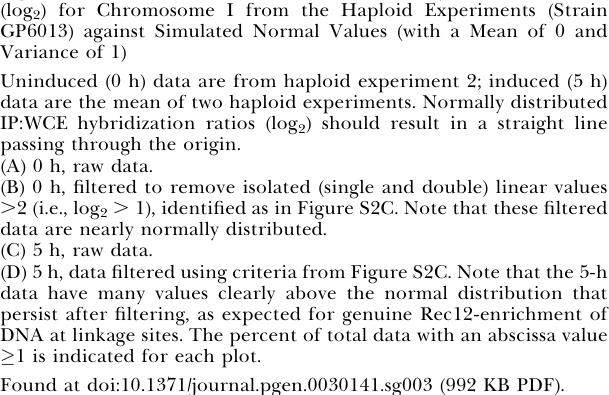
Figure S4. Quantile-Quantile Plots of IP:WCE Hybridization Ratios (log 2 ) for Chromosome I from the Diploid Experiment (Strain GP6203) against Simulated Normal Values (with a Mean of 0 and Variance of 1) Normally distributed IP:WCE hybridization ratios (log 2 ) should result in a straight line passing through the origin.